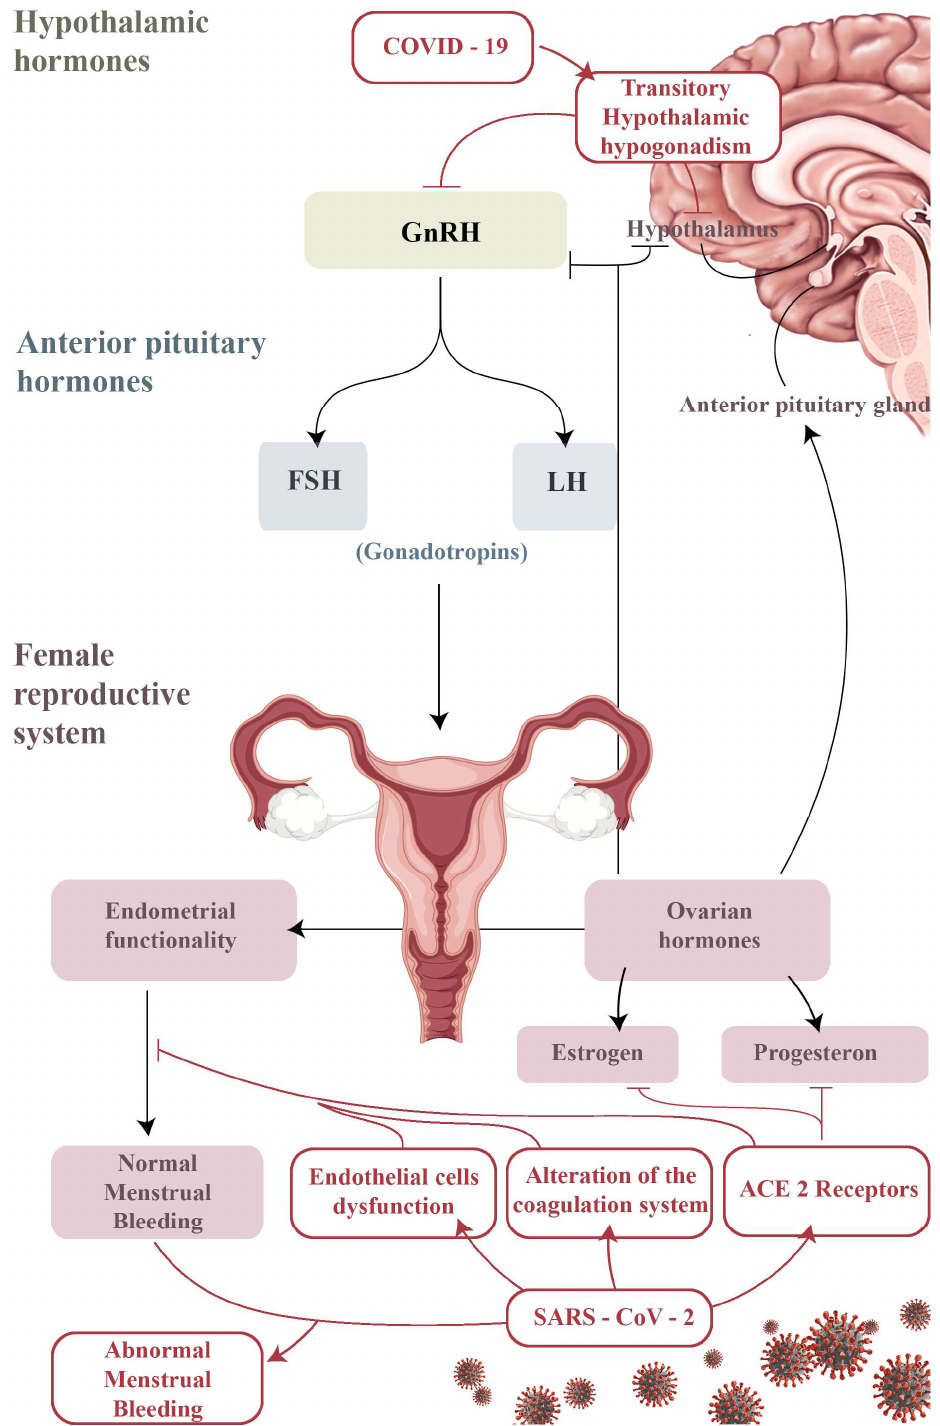
Figure 2. The hypothalamic–pituitary axis ovary endometrium; a summary table of the possible correlations between SARS-CoV-2 infection and transitory alterations of the neuroendocrine and gynecological systems. COVID-19 may lead to a transient suppression of the physiological secretory pulsating activity of the hypothalamic Gonadotropin-Releasing Hormone (GnRH), thus resulting in a temporary hypothalamic hypogonadism. Moreover, SARS-CoV-2 binding to ACE-2 receptors, as- sumed to be present in endometrial and ovarian tissue as well, could bring to alterations in endocrine pathways and/or coagulation disorders, in both cases resulting in abnormal menstrual bleed- ing.